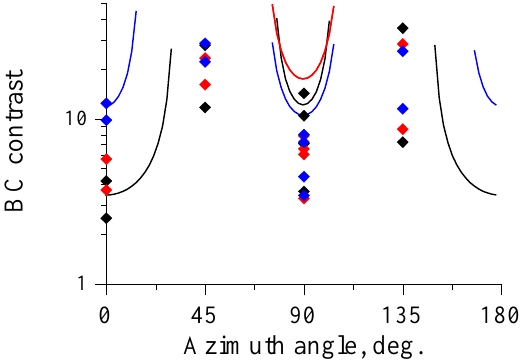
Figure 13. Comparison between experimental BC contrasts (symbols) and a local balance model (curves). Black symbols/curve — S-band, red — C-band, and blue — X-band.